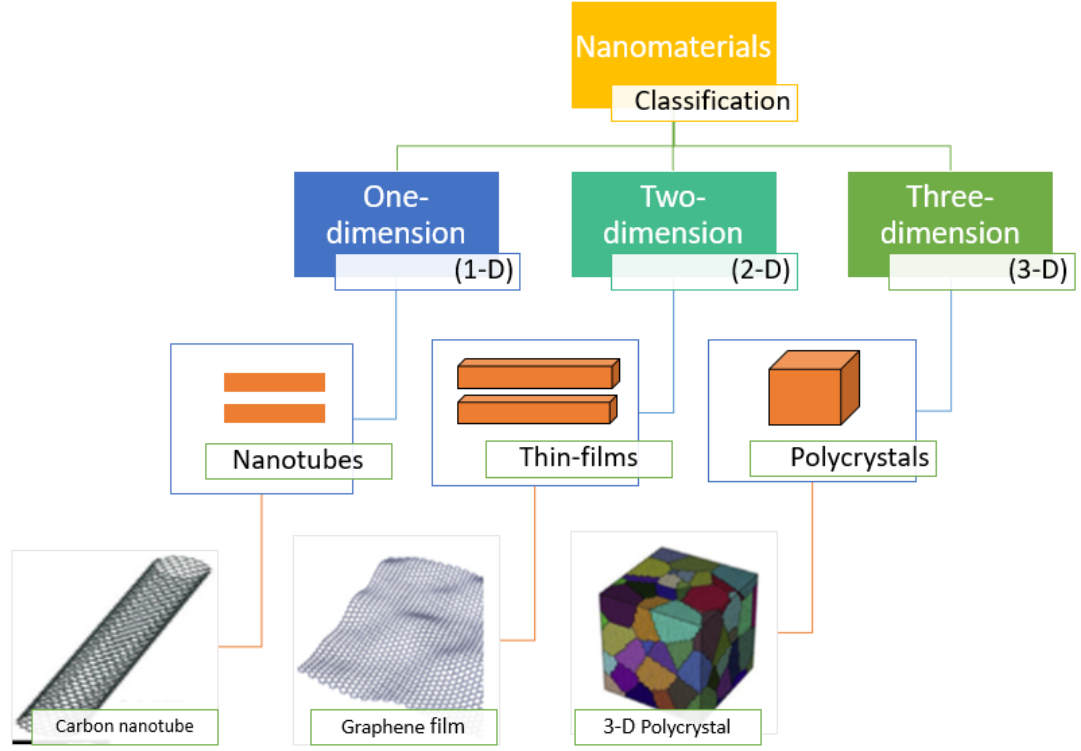
Figure 1. Diagrammatic portrayal of 1D, 2D, and 3D nanomaterials.